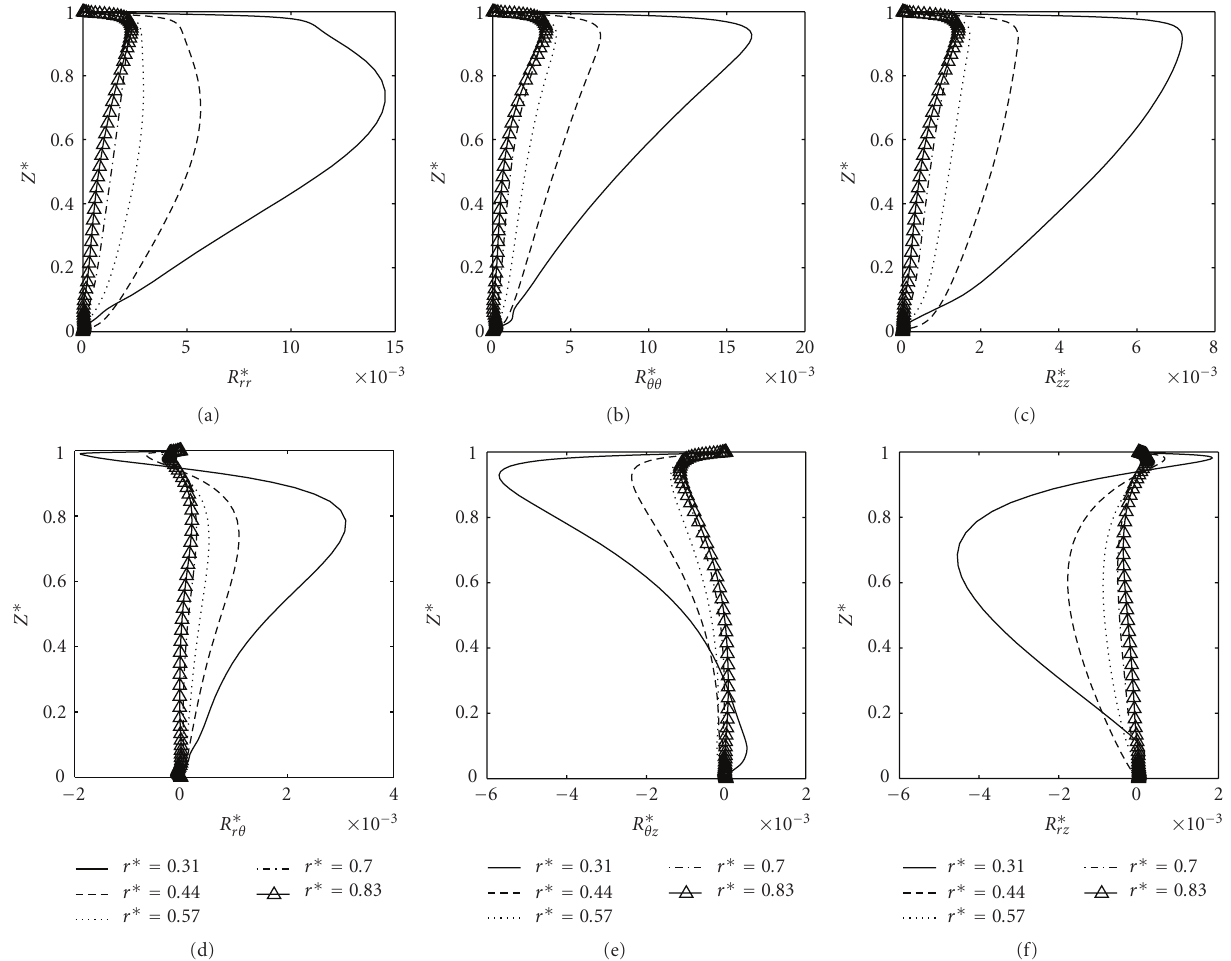
Figure 25: Axial profiles of the six Reynolds stress tensor components for Re = 10 6 , G = 0 . 02, and C w = 2500 at di ff erent radial locations r ∗